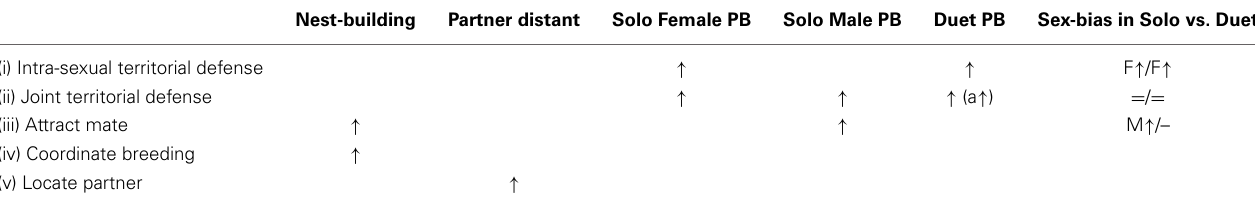
Table 1 | Predictions of hypotheses for the function of female song and answering